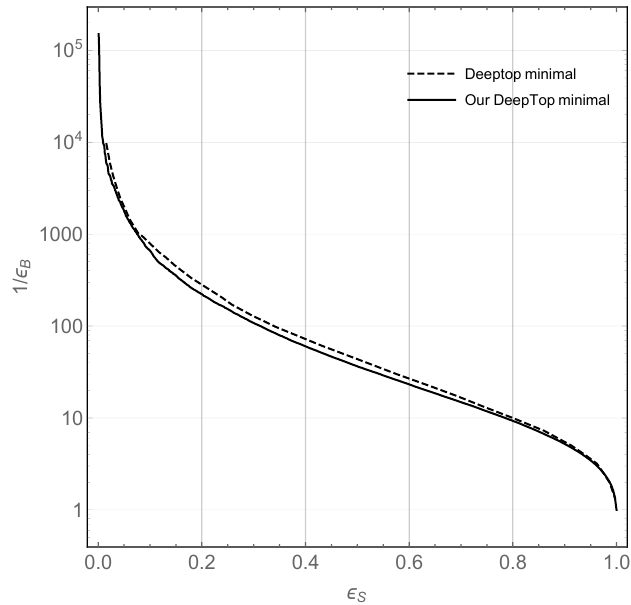
Figure 9 . ROC curves validating our implementation of the DeepTop tagger with minimal prepro- cessing (solid) against the original (dashed). The latter was obtained by digitizing the \DeepTop minimal" curve in (cid:12)gure 8 of [39]. We see that the agreement is excellent.